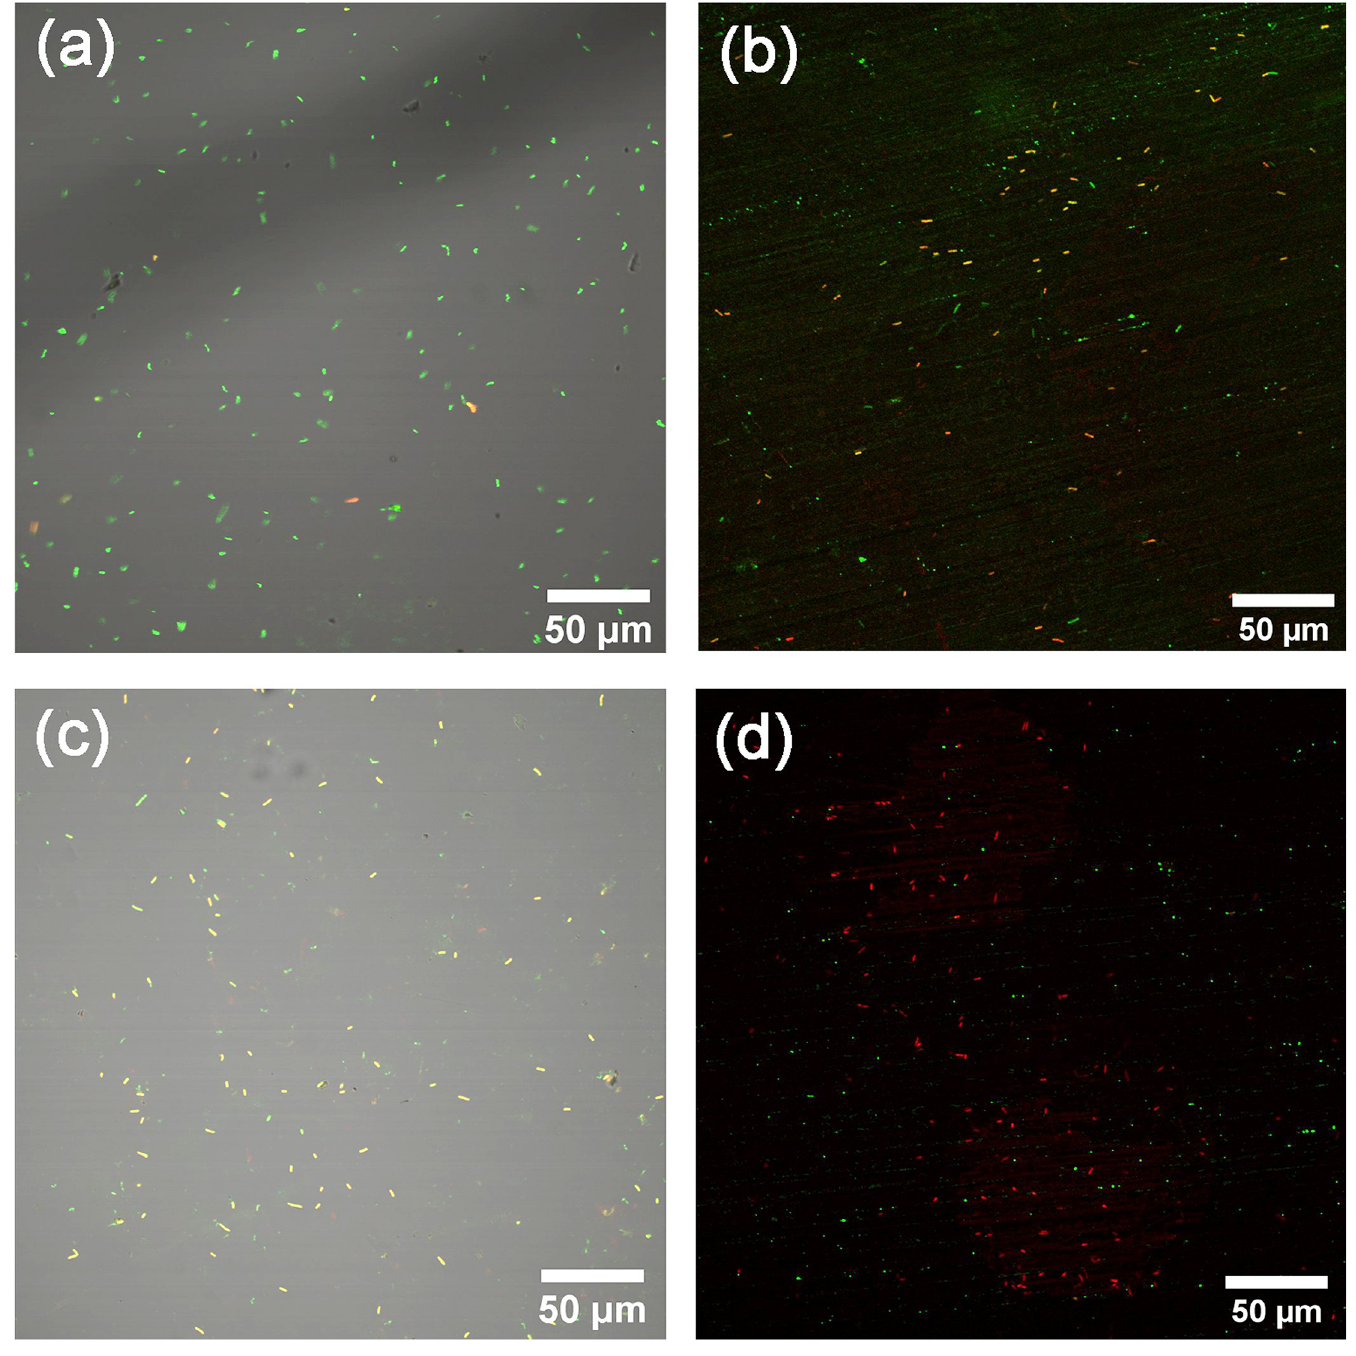
Fig 11. Representative fluorescence microscopy images of viable/dead bacteria on glass with merged transmitted light (a, c) and on one-day tarnished/corroded Cu surfaces (b, d) exposed to E. coli (OD 600 = 0.9 ± 0.1) and stained with an viable/dead staining assay after 0 min (+10–15 min imaging time) (a-b) and after 20 min (+10– 15 imaging time) (c-d). Live (green) and dead (red) cells were dyed by means of SYTO9 (a green fluorescent nucleic acid stain) and PI (propidium iodide, a red- fluorescent nuclear and chromosome counterstain).